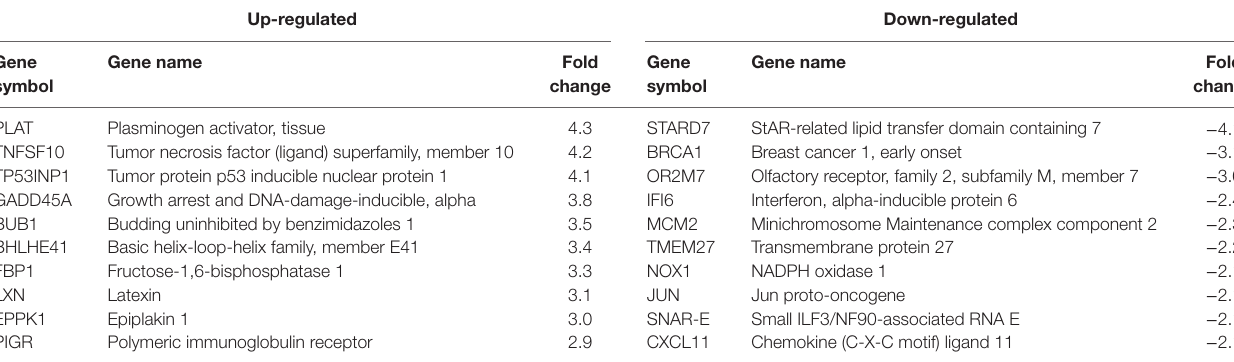
TaBle 1 | HPV11E6 Top 10 up- and downregulated gene based on either the extent of up- or downregulation or on their known involvement in cellular transformation. Up-regulated Down-regulated